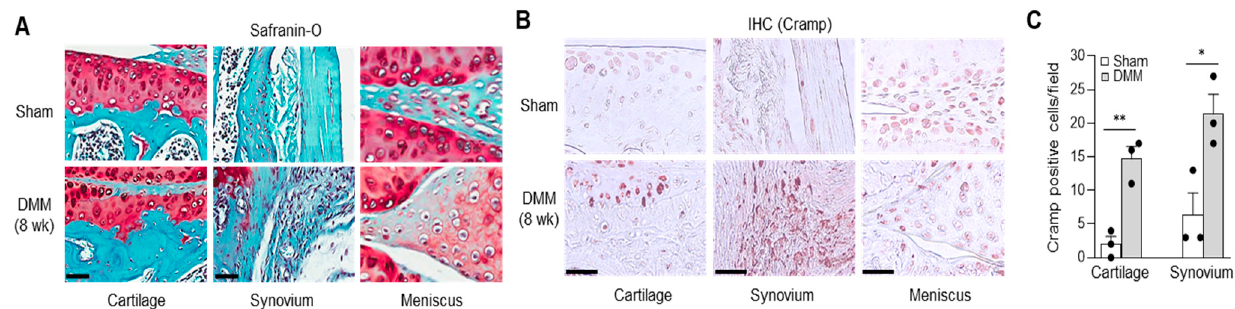
Figure 2. Cramp is up-regulated in cartilage and synovium during experimental osteoarthritis (OA). ( A ) Safranin-O staining of mouse cartilage, synovium and meniscus harvested at 8 weeks after destabilization of the medial meniscus (DMM) surgery. ( B , C ) Immunohistochemical staining (IHC) for Cramp in cartilage, synovium and meniscus. Bars = 50 μ m. Values are the means ± SEM. n = 3 for each group. * p < 0.05, ** p < 0.01 versus sham.